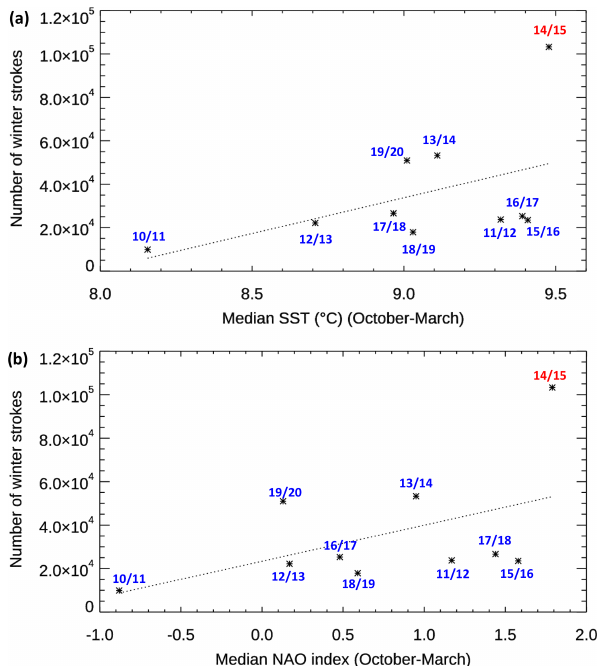
Figure 6. Number of lightning strokes detected by WWLLN in in- dividual winter periods (October–March) and corrected by the rela- tive detection efficiency maps as a function of (a) the median winter SST in the eastern North Atlantic and (b) the median NAO index calculated over the same period. The dashed lines show the linear